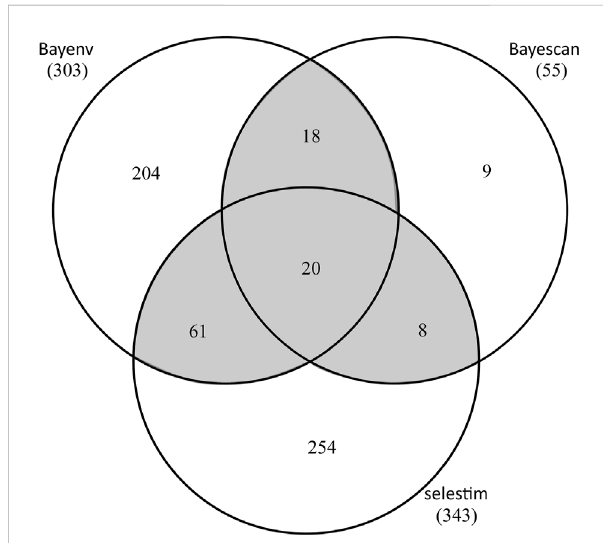
FIGURE 4 Number of T. hemsleyanum SNPs detected in three F ST outlier tests. Shaded overlapping regions (outliers in > 2 tests) represent SNPs deemed as outliers in this